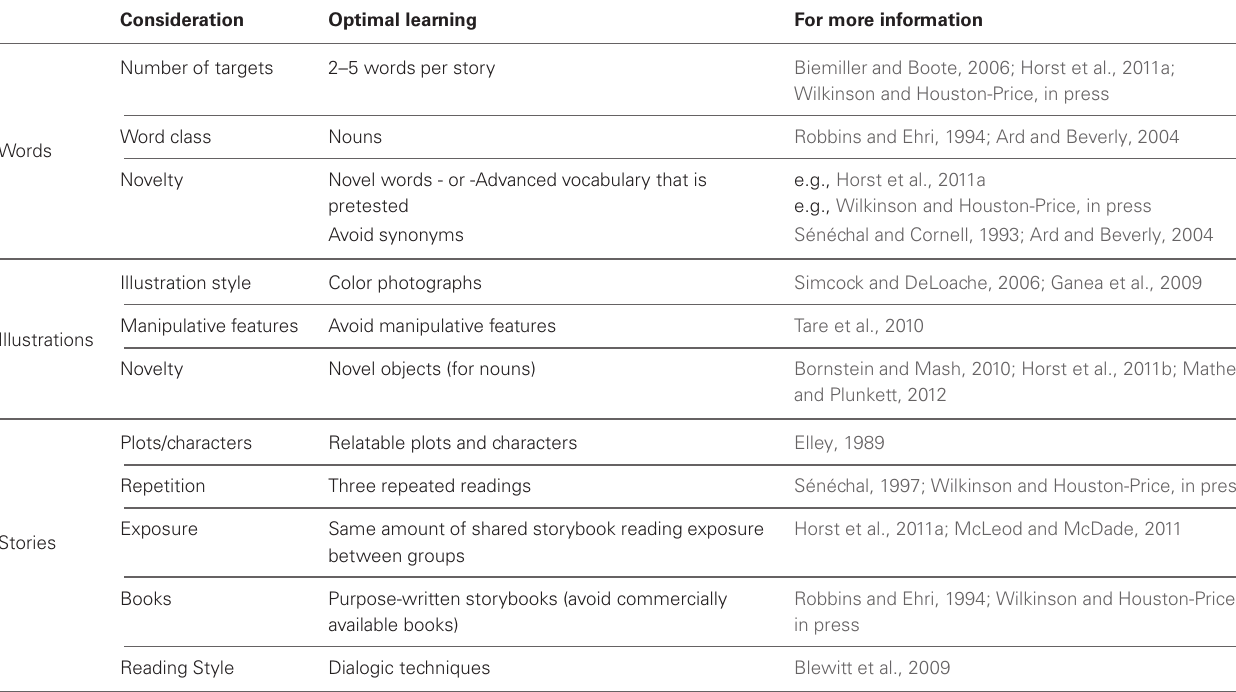
Table 1 | A summary of considerations for research and interventions for using shared storybook reading to improve